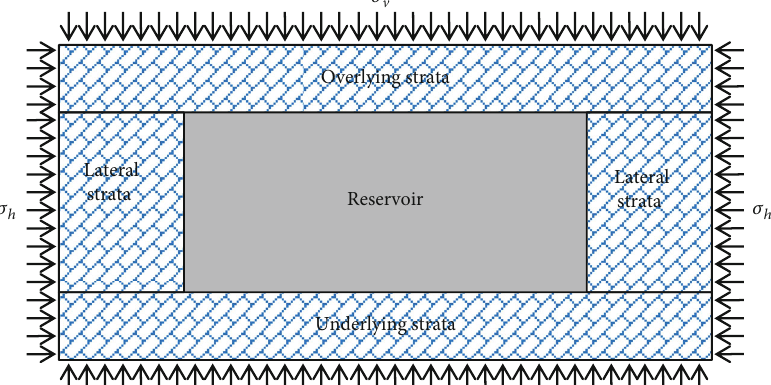
Figure 2: Schematic illustrating the reservoir